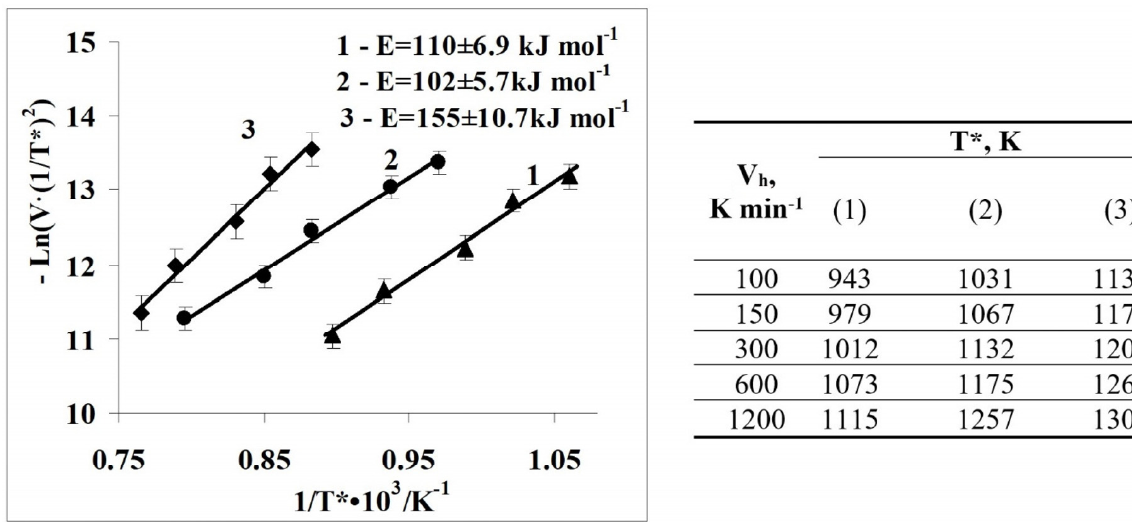
Figure 15. Linear fitting of the − ln(V h (1/T*) 2 ) vs. 1/T* · 10 3 plot to extract effective activation energy of the magnesiothermic reactions in the MoO 3 + 3Mg (1), MoO 3 + 1.5Mg + C (2), CuO + MoO 3 + 1.2Mg + 2.15C (3) mixtures. V h = 100–1200 K min − 1